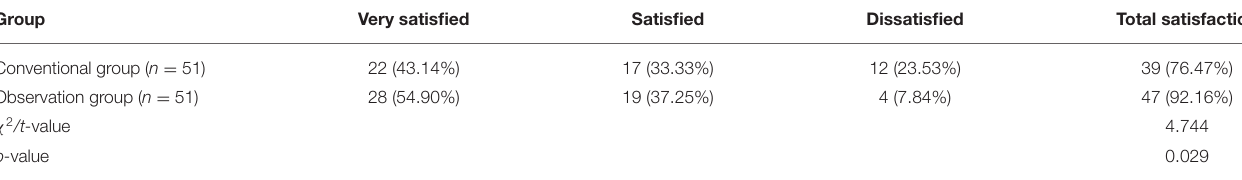
TABLE 3 | Comparison of satisfaction between the two groups ( n , %). Group Very